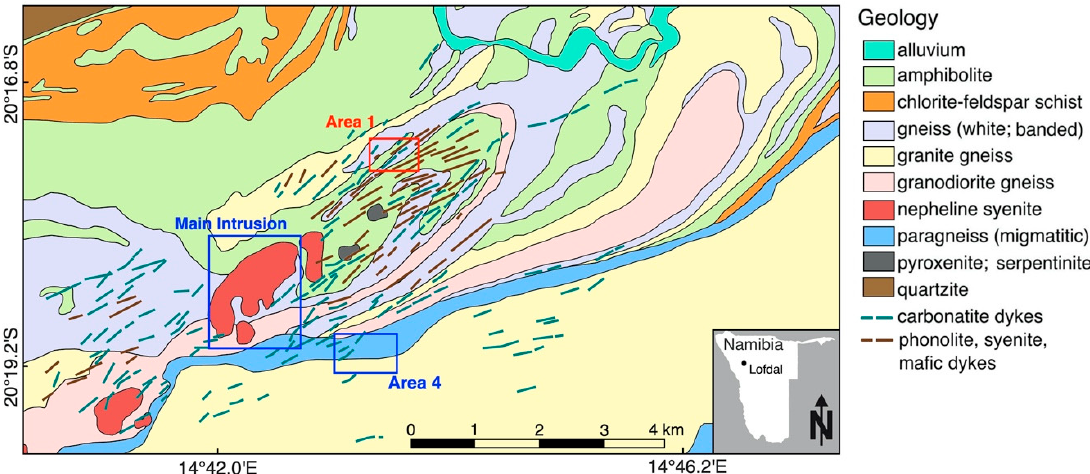
Figure 1. Geological map of the Lofdal Alkaline Carbonatite Complex, including the location of the dyke swarms. Area 1 is located northeast from the Main intrusion (adapted from the Geological Survey of Namibia).